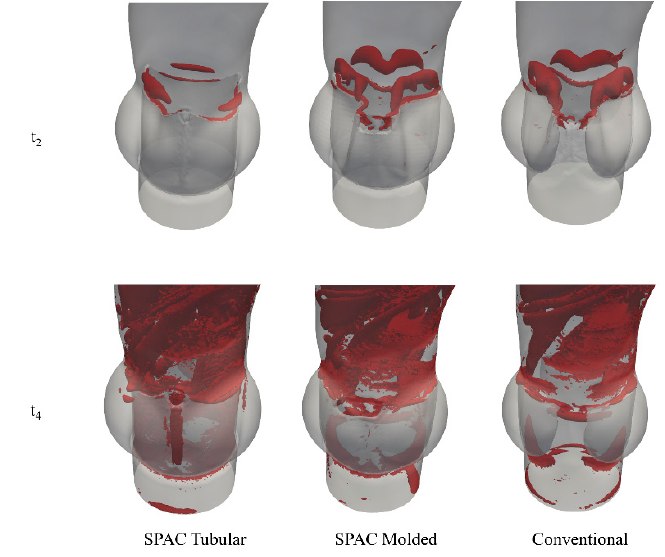
Figure 11. Comparison of Q-criterion isosurface during the acceleration phase of systole.